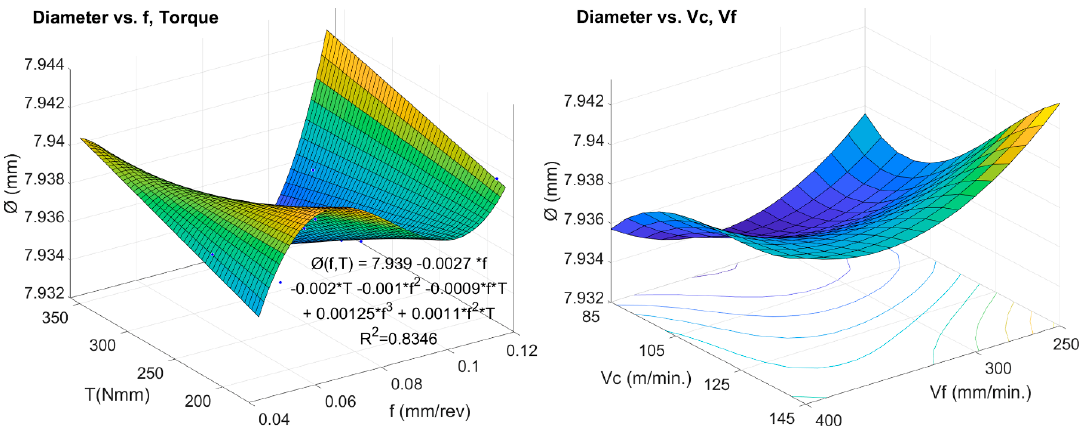
Figure 10. E ff ects of torque, cutting speeds and feed rates on the diameter of the Figure 10. Effects of torque, cutting speeds and feed rates on the diameter of the holes.